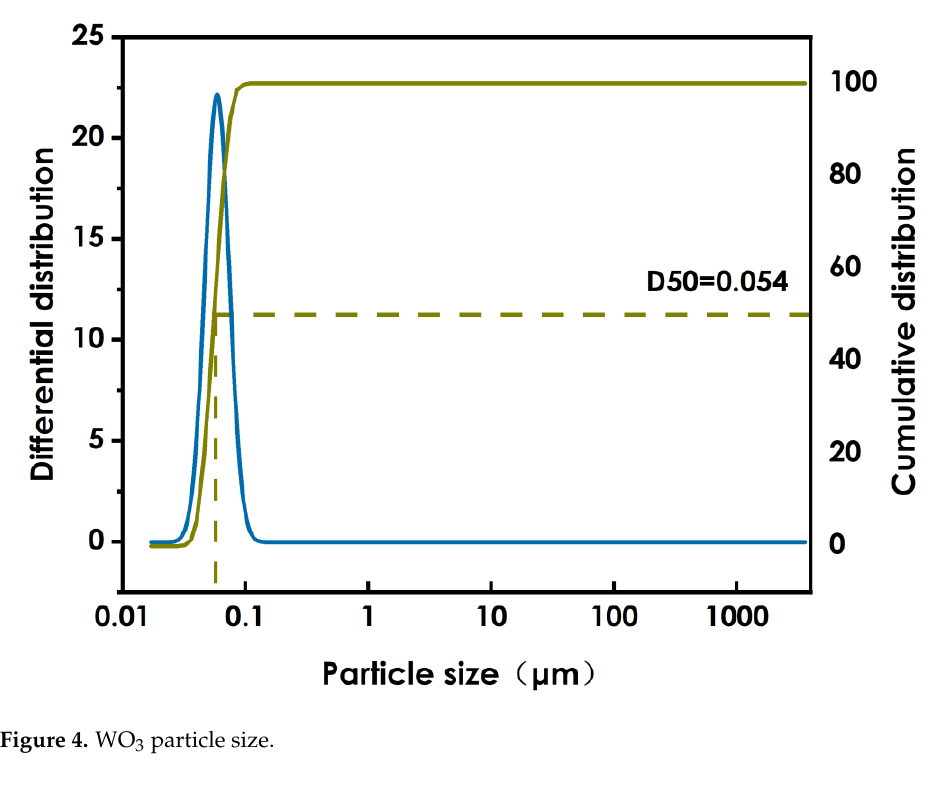
Figure 4. WO 3 particle size.